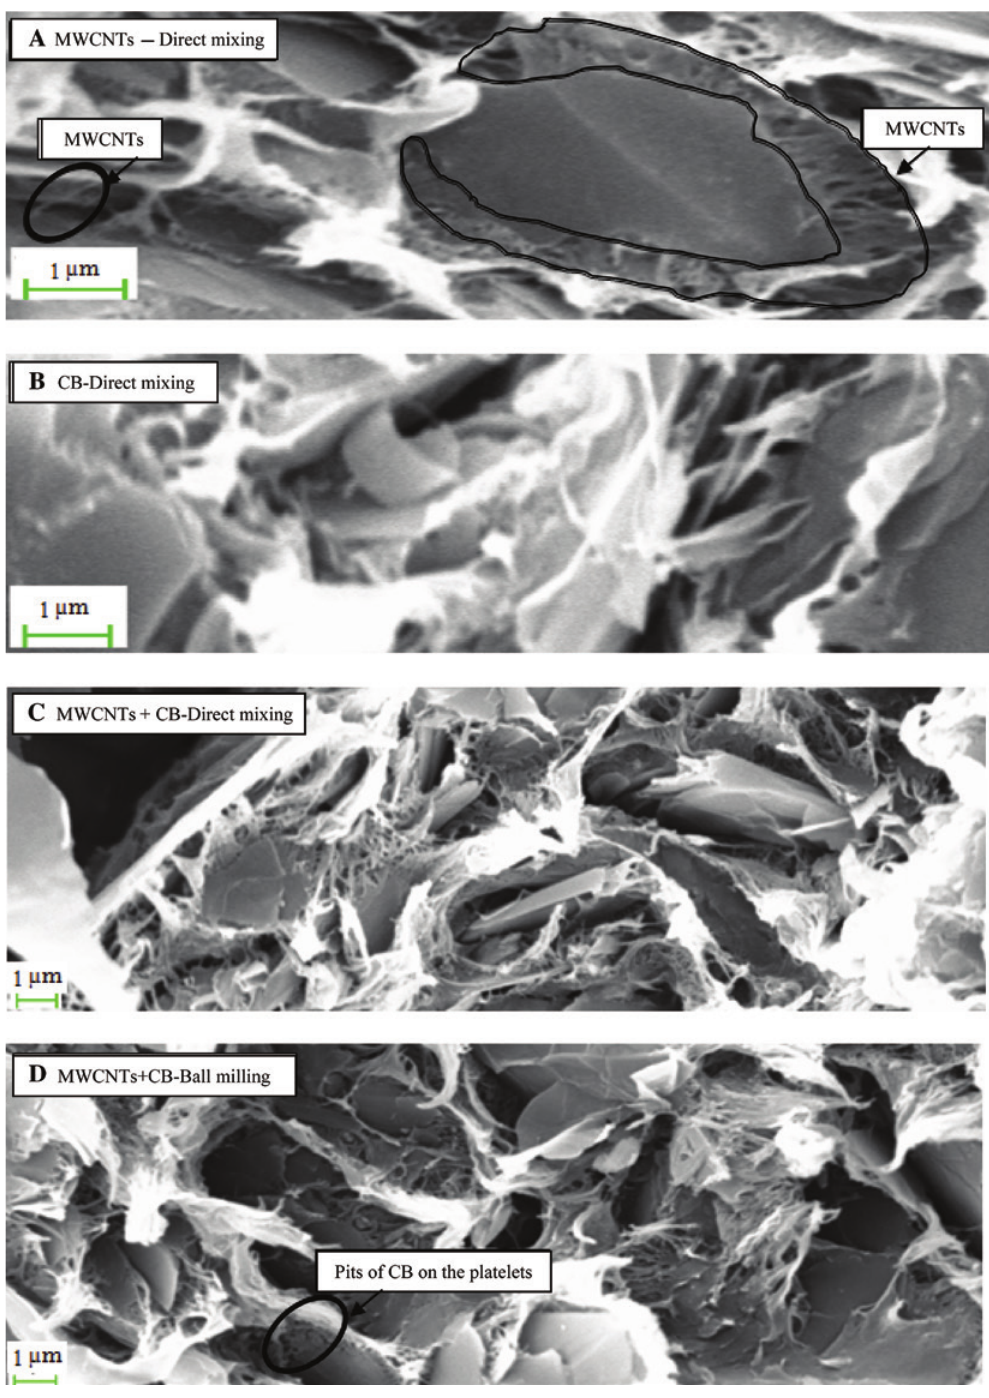
Figure 12: The SEM fracture micrographs of the direct-mixed (A) PP/SG/xGnP/7.5MWCNTs, (B) PP/SG/xGnP/7.5CB, (C) PP/SG/ xGnP/5MWCNTs/2.5CB and (D) ball milled PP/SG/xGnP/3.75MWCNTs/3.75CB composites at different